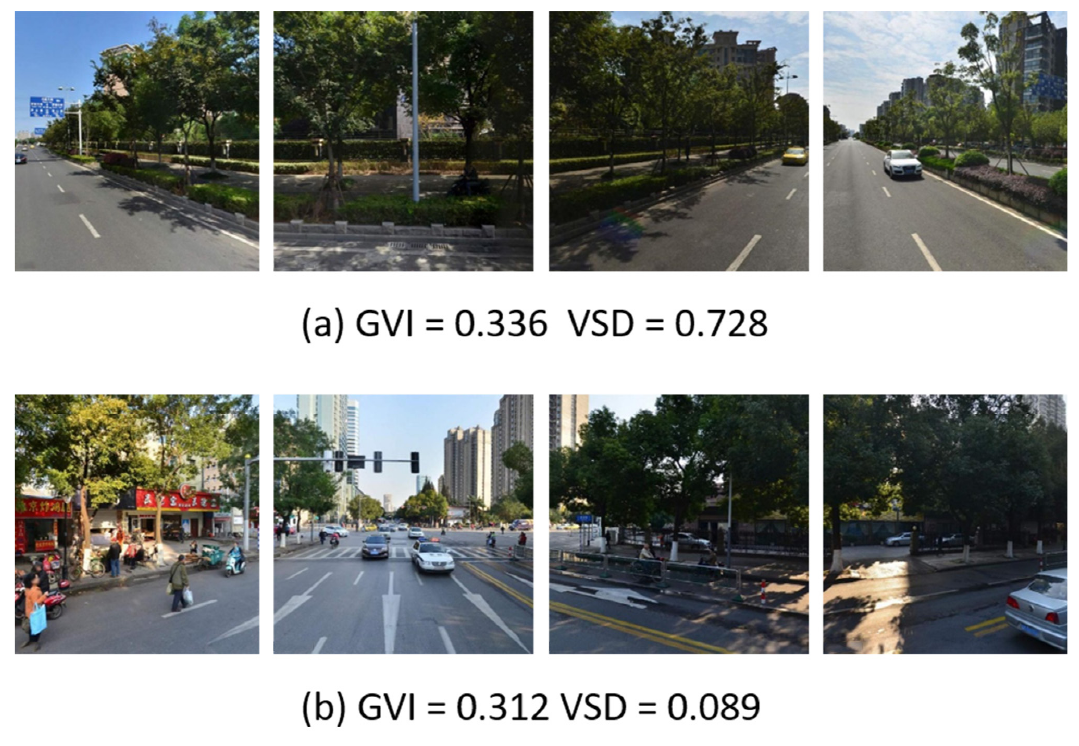
Figure 14. Examples of roads with di ff erent levels of VSD. ( a ) Street with high VSD in the southern part of the city. Trees and shrubs are combined in layers. ( b ) Street with low VSD in the city center. Trees are the only vegetation.